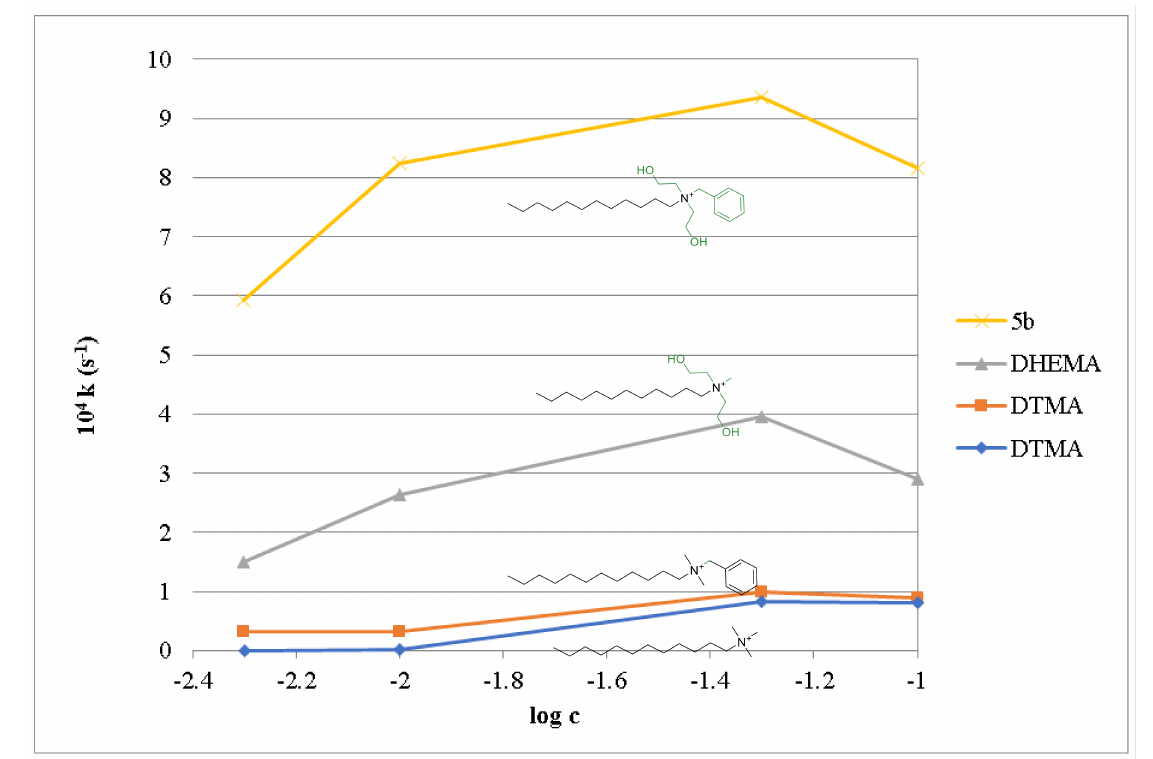
Figure 3. Commercially used compounds at pH 11. The influence of QAS structure on the decontamination ef- fect (rate constant) at pH 11; DTMA ( N -dodecyl- N , N , N -trimethylammonium chloride), BAC ( N -benzyl- N , N -dimethyl- N -dodecylammonium chloride), DHEMA ( N,N -bis(hydroxyethyl)- N -dodecyl- N -methylammonium chloride) and 5b ( N -benzyl- N , N -bis(2-hydroxyethyl)dodecan-1-aminium chloride; green color highlights the positive moiety to increase the decontamination effect. The decrease in activity at high concentrations is due to an excess of surfactant. This so-called empty micelle effect has been previously described